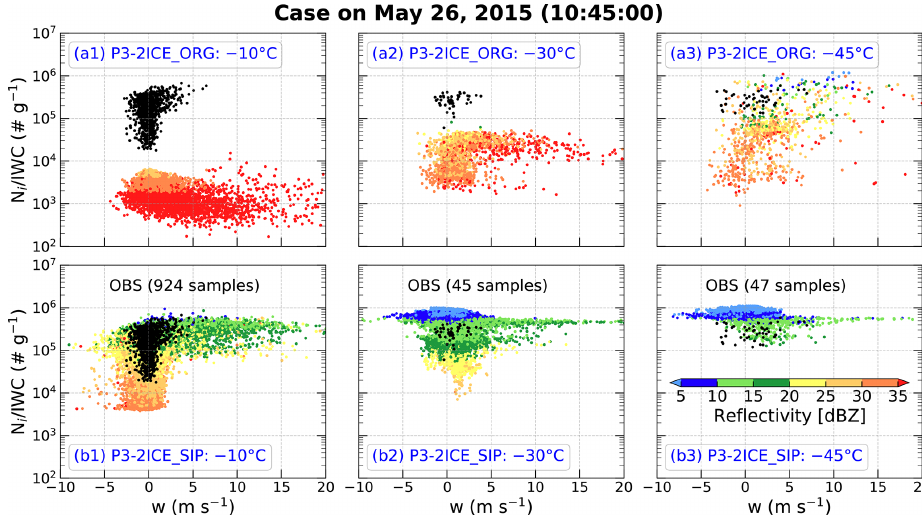
Figure 9. Scatter plots of (black) observed and (colorized) simulated ice number concentration ( N i , no.m − 3 ) divided by ice water content (IWC, gm − 3 ) (denoted as N i / IWC) as a function of vertical velocity ( w , ms − 1 ) in regions with IWC > 1gm − 3 at temperatures of (a1, b1) − 10 ◦ C, (a2, b2) − 30 ◦ C, and (a3, b3) − 45 ◦ C. The observations are from the two flights, SAFIRE Falcon 20 and NRC Convair 580 (shown in Fig. 1 of Huang et al., 2021), during the Cayenne field campaign, and the observed temperature ranges of samples at the three levels are − 12 . 6 to − 7 . 9 ◦ C, − 30 . 4 to − 29 . 7 ◦ C, and − 44 . 7 to − 43 . 6 ◦ C, respectively. The simulation using the original P3 two-ice category configuration is shown in (a1) – (a3) , and the simulation using the P3 two-ice category configuration including the three SIP processes is shown in (b1) – (b3) . The simulations at the three temperature levels are interpolated from the 1km model outputs. The scatter plots of simulations are color-coded according to the magnitude of radar equivalent reflectivity factor